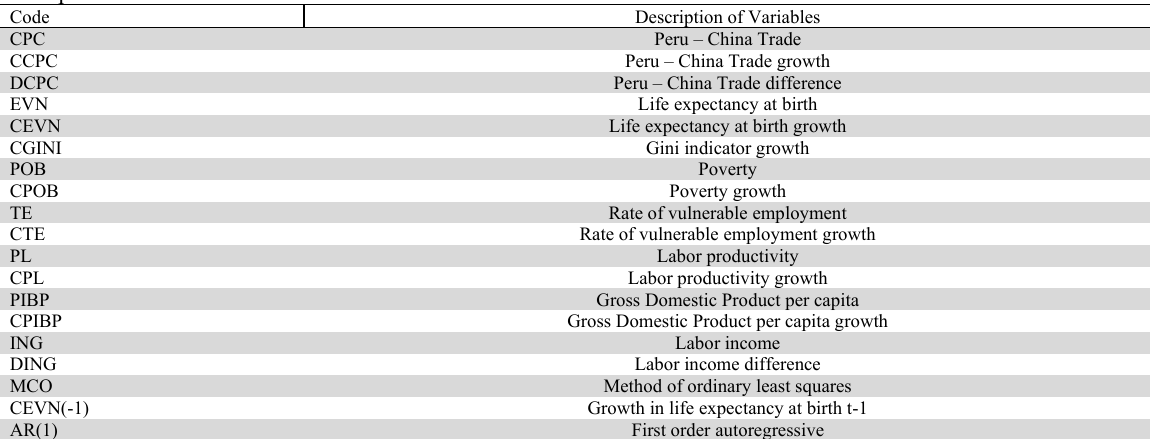
Description and code of Variables